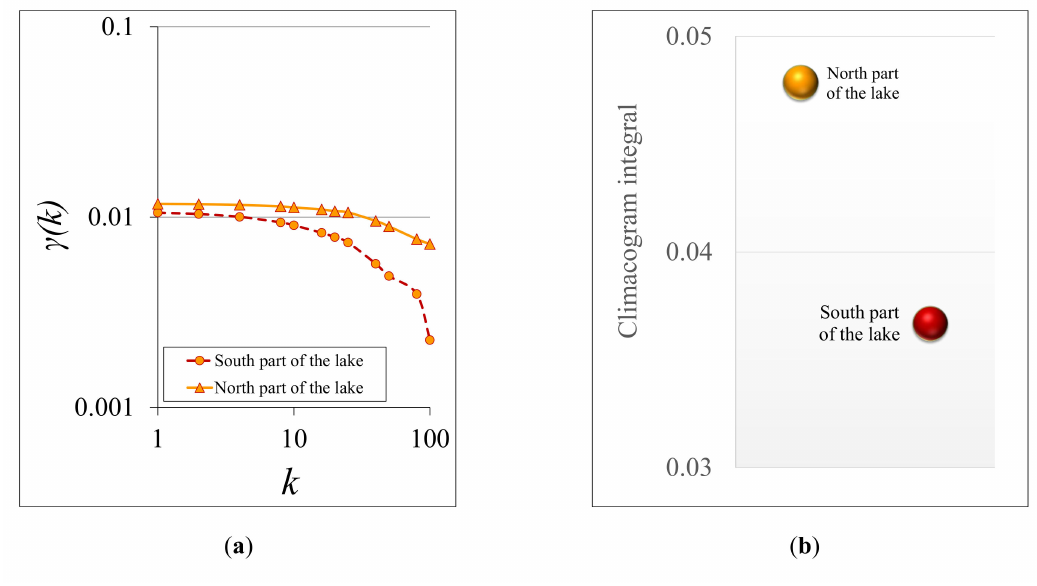
Figure 14. ( a ) Climacogram for each scale of Figure 6b,c; ( b ) rate of alteration of clustering of Figure